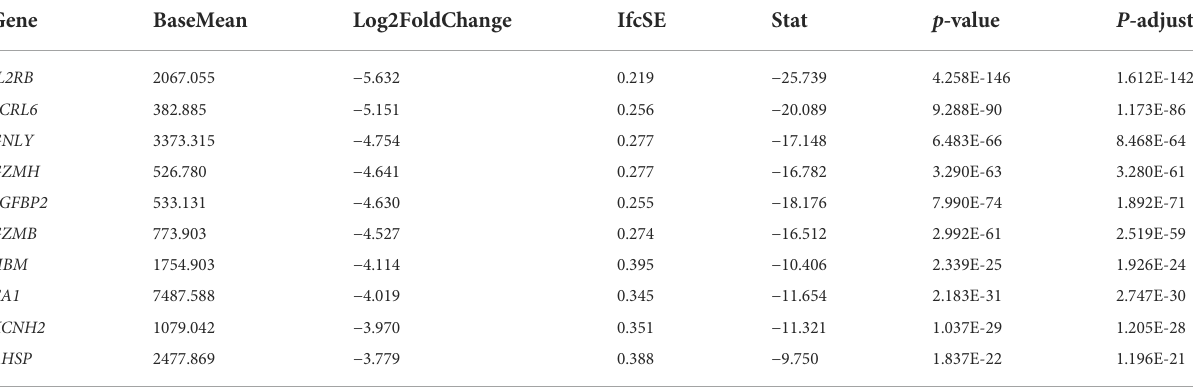
TABLE 3 The top 10 down-regulated genes. Gene BaseMean